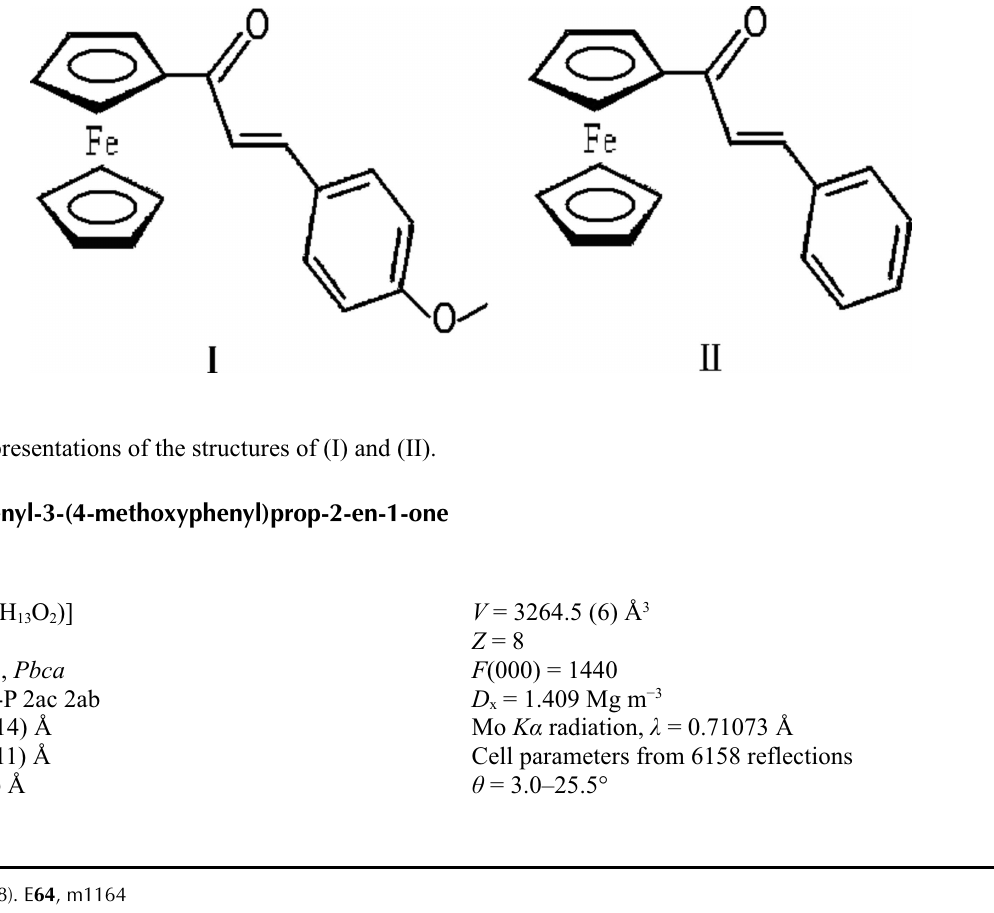
Figure 3 Unit cell packing of (I) showing the hydrogen bonded chains via C8–H8···O1 and C3–H3··· π (Cps ring) inter-molecular interactions; for clarity, H atoms not involved in hydrogen bonding have been omitted.